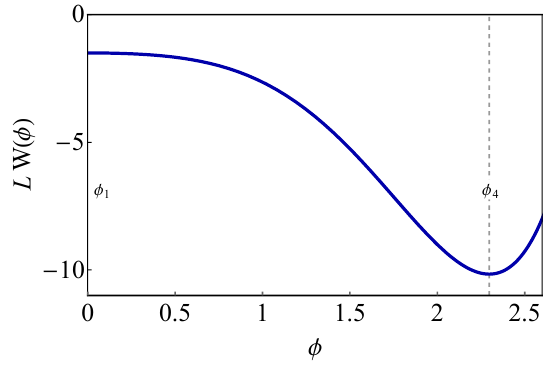
Figure 2 . Superpotential of our